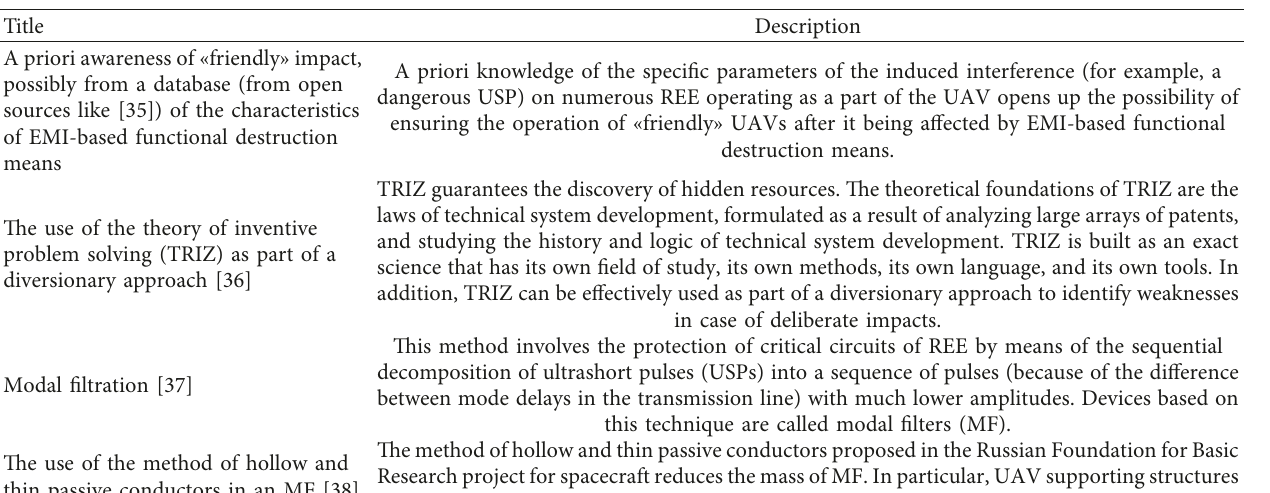
Table 1: Suggested approaches and